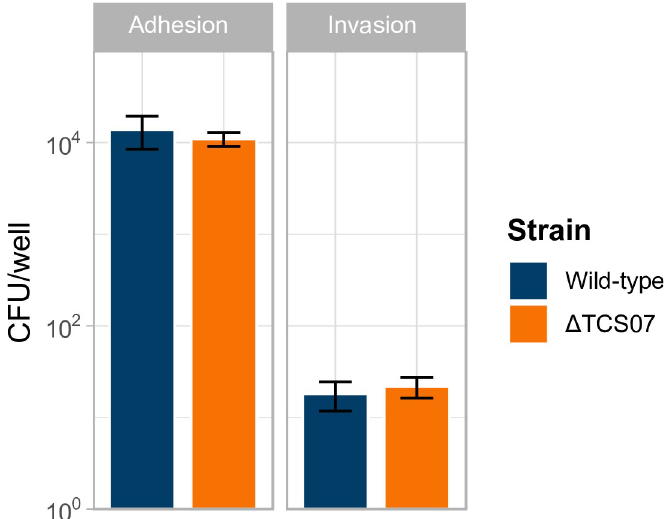
Fig 5. TCS07 does not affect adherence or invasion. Wild type and Δ TCS07 were inoculated from plate into DMEM to an OD 600 = 0.2 and added to a confluent monolayer of A549 cells. Cells were incubated for 2 or 3 h for adherence or invasion assays, respectively. For adherence, non-adherent bacterial cells were washed away with PBS, and adherent cells were spread-plated to determine CFU counts. For invasion, non-invasive bacterial cells were killed by replacing the medium with DMEM supplemented with penicillin G and gentamycin and incubated for 1 h, before washing and plating to determine CFU counts. Adherence assays were performed in triplicates four individual times and invasion assays were performed in triplicates two times; error bars depicting standard deviation.